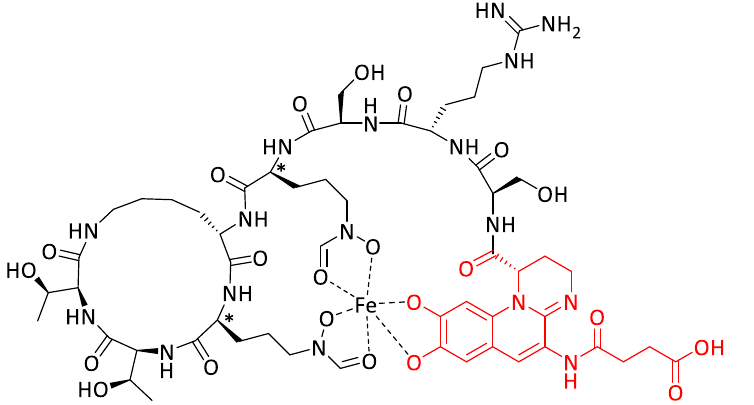
Figure 44. Structure of pyoverdine D. The chromophore unit is shown in red. The formylhydroxyornithine residues are highlighted by an asterisk (*).